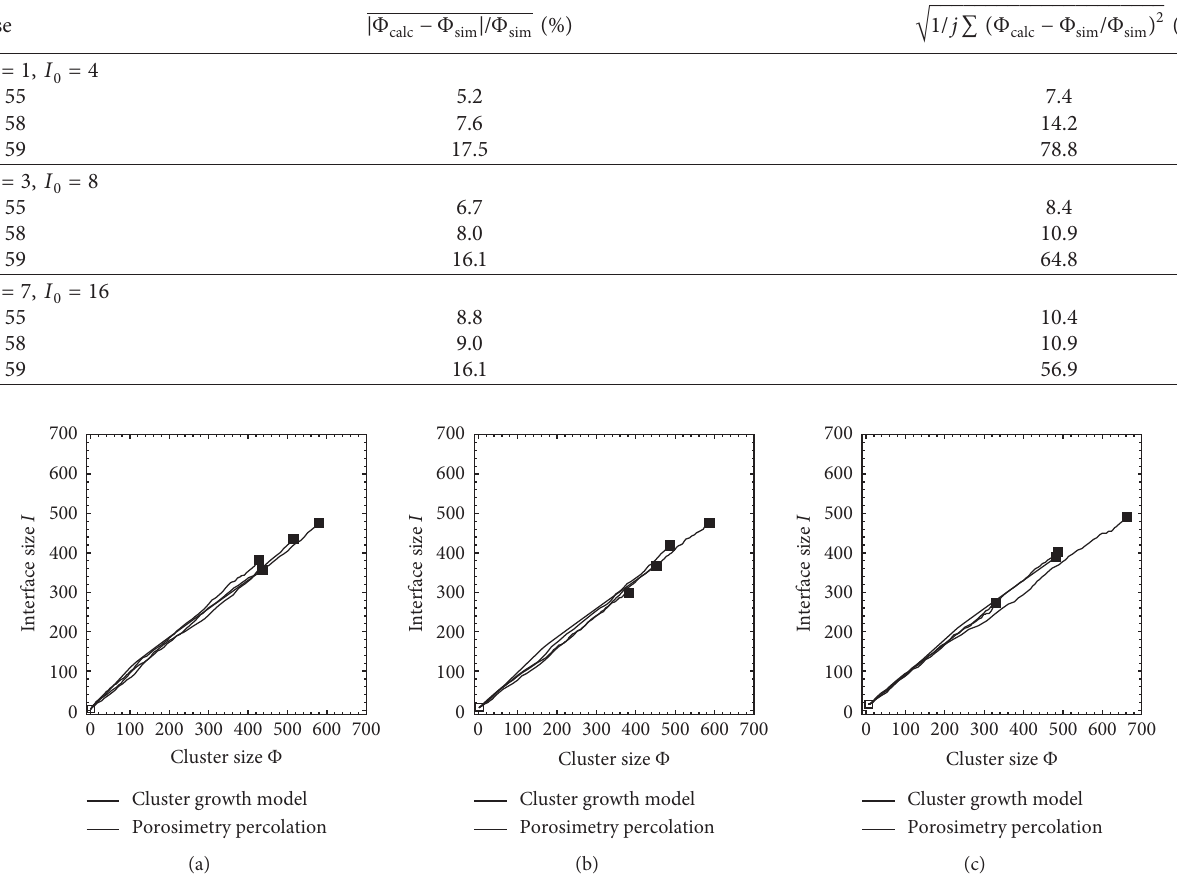
� 1, I � 4), (b) maximum perimeter tromino 0 0 � 7, I � 16) starting sets. The thick lines show the evolution of the cluster 0 0